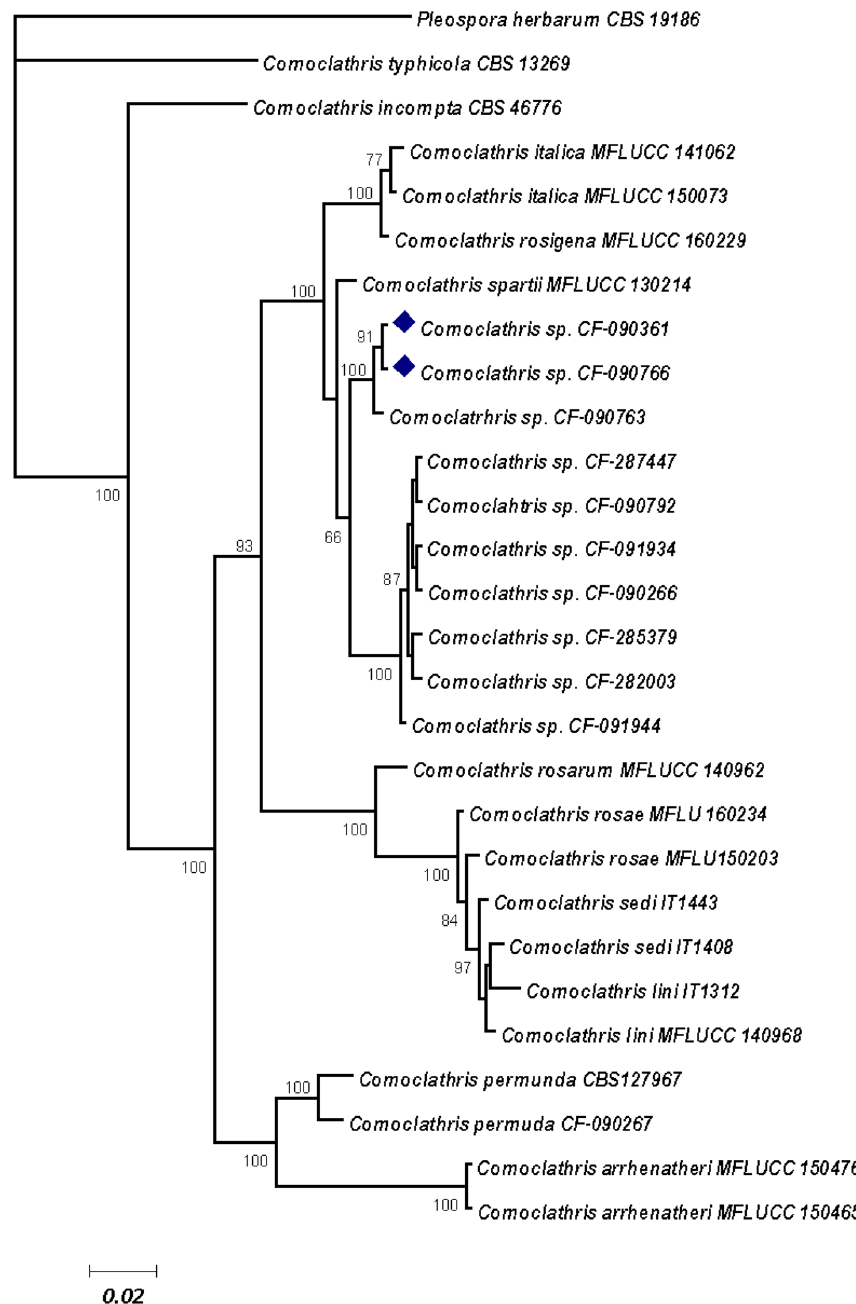
Figure 1. Bayesian inference of the ITS-28S sequence alignments of Comoclathris species. Clade probability values are indicated respectively on the